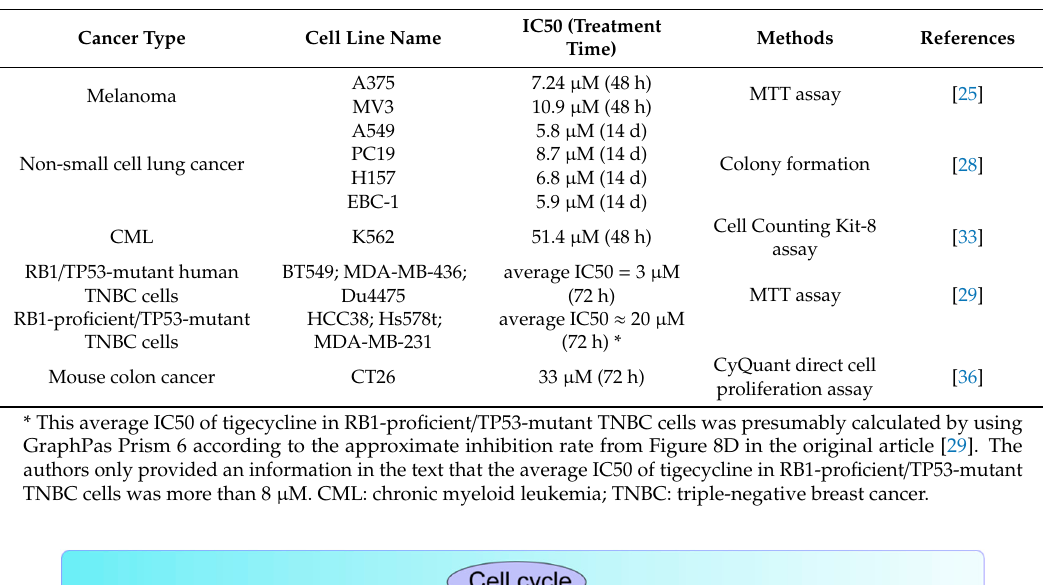
Table 1. IC50 of tigecycline in several types of tumor cells. Please note that direct comparison of the IC50 data is not straightforward since obtained in di ff erent conditions with di ff erent methods.